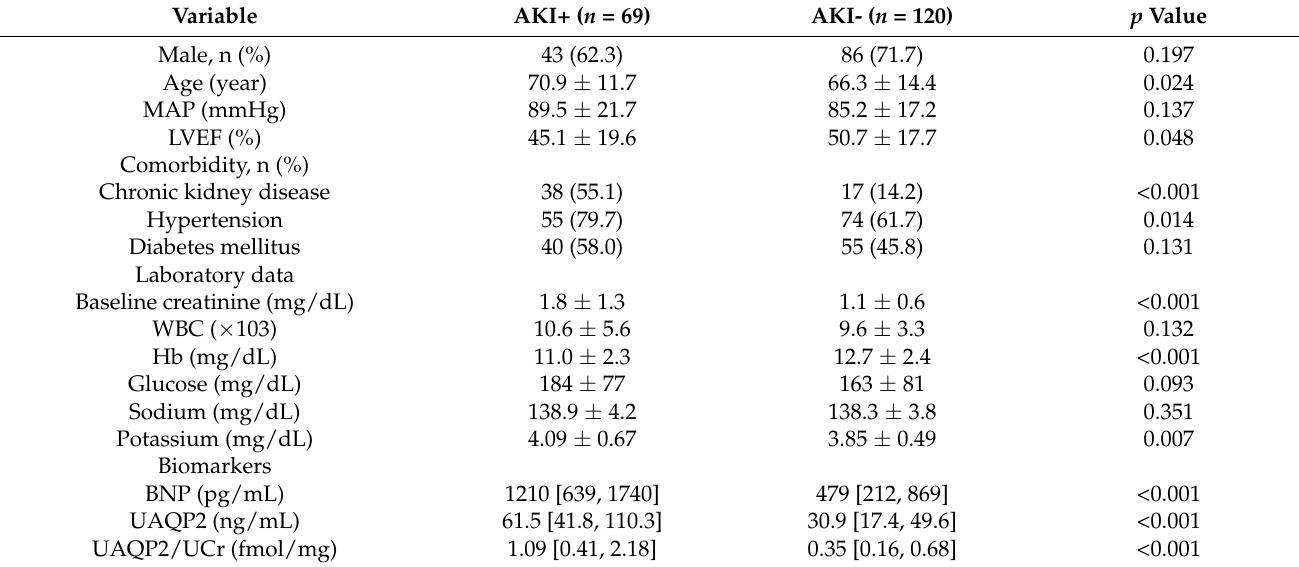
Table 1. Baseline characteristics of patients admitted due to heart failure with or without